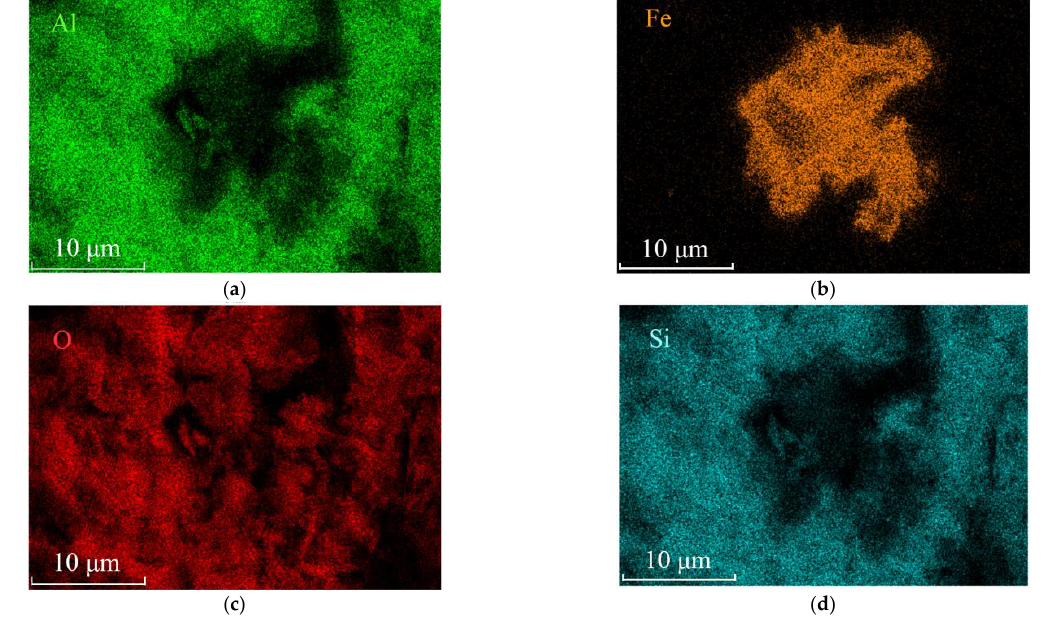
Figure 6. EDS mapping of the clustered acicular minerals. ( a ) Element Al distribution map; ( b ) Ele- ment Fe distribution map; ( c ) Element O distribution map; ( d ) Element Si distribution map of the same area shown in Figure 5a.